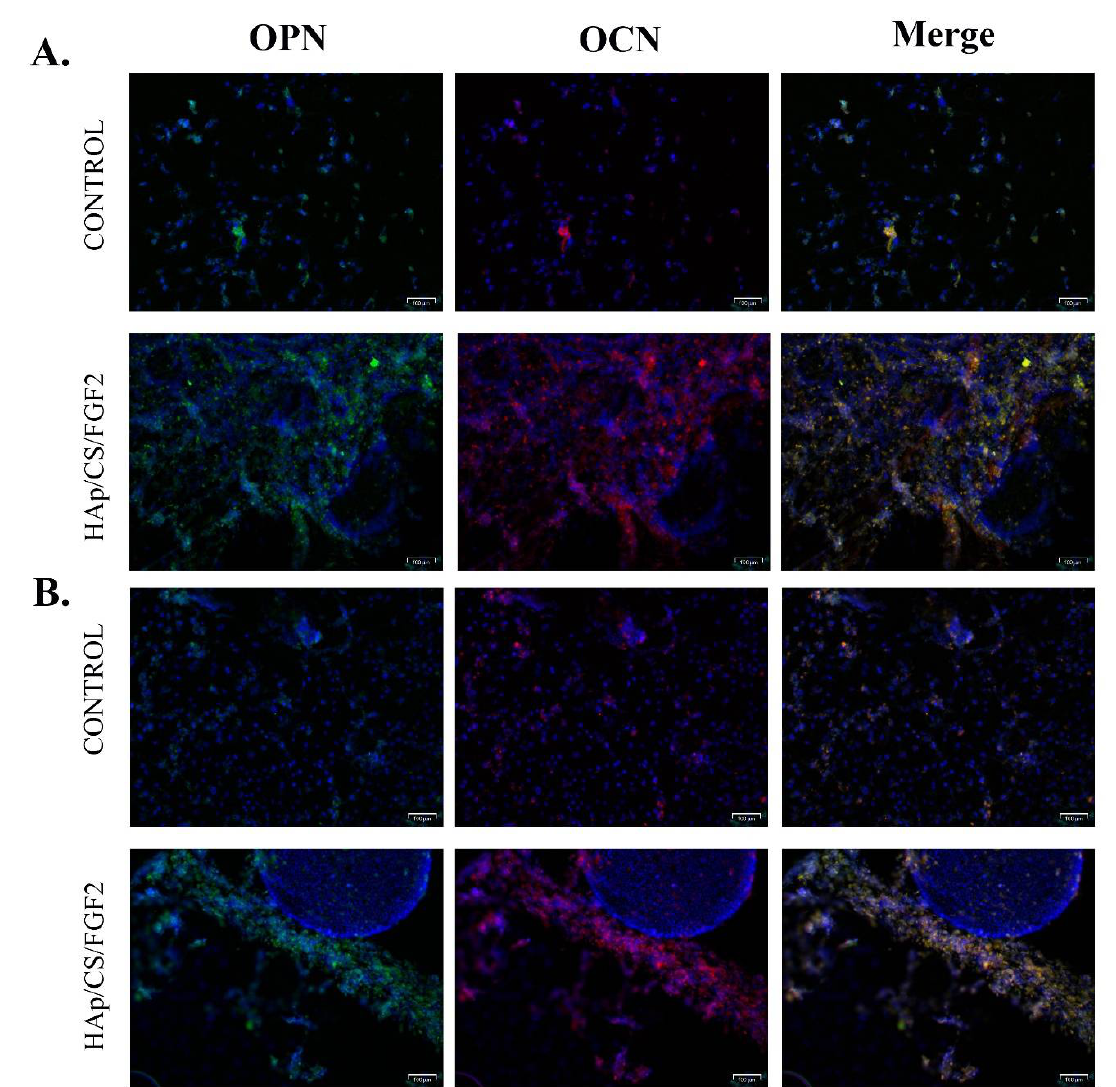
Figure 9. Fluorescence micrographs (scale bar 100 µ m) revealing the protein expression of osteogenic specific markers OPN (green) and OCN (red) after 14 ( A ) and 21 ( B ) days of MC3T3-E1 cells’ exposure to osteogenic inductors in contact with control surfaces and HAp/CS/FGF2 coatings. Cell nuclei are stained with DAPI (blue).